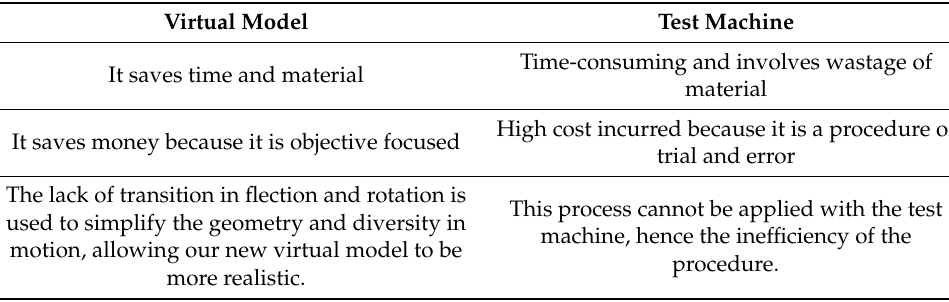
Table 2. Comparison between the virtual model procedure and the test machine. Virtual